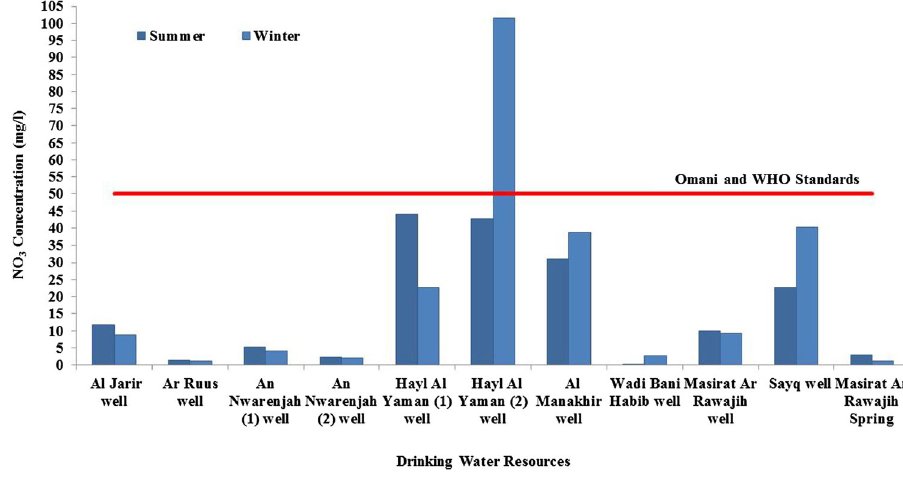
Fig. 3 Nitrate concentration